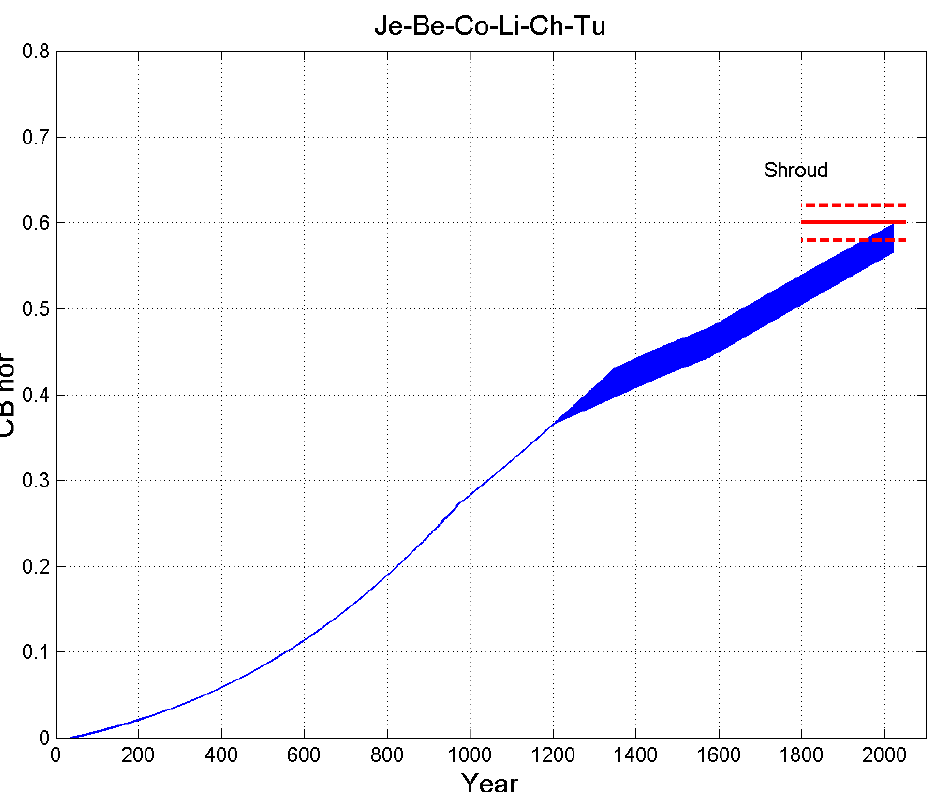
Table 3. Predicted average, minimum, and maximum 𝐶𝐵 (cid:3041)(cid:3042)(cid:3045) in the alleged paths of the Shroud in the year 2021, with their average standard deviations due to constants’ uncertainties (see Figure 1).